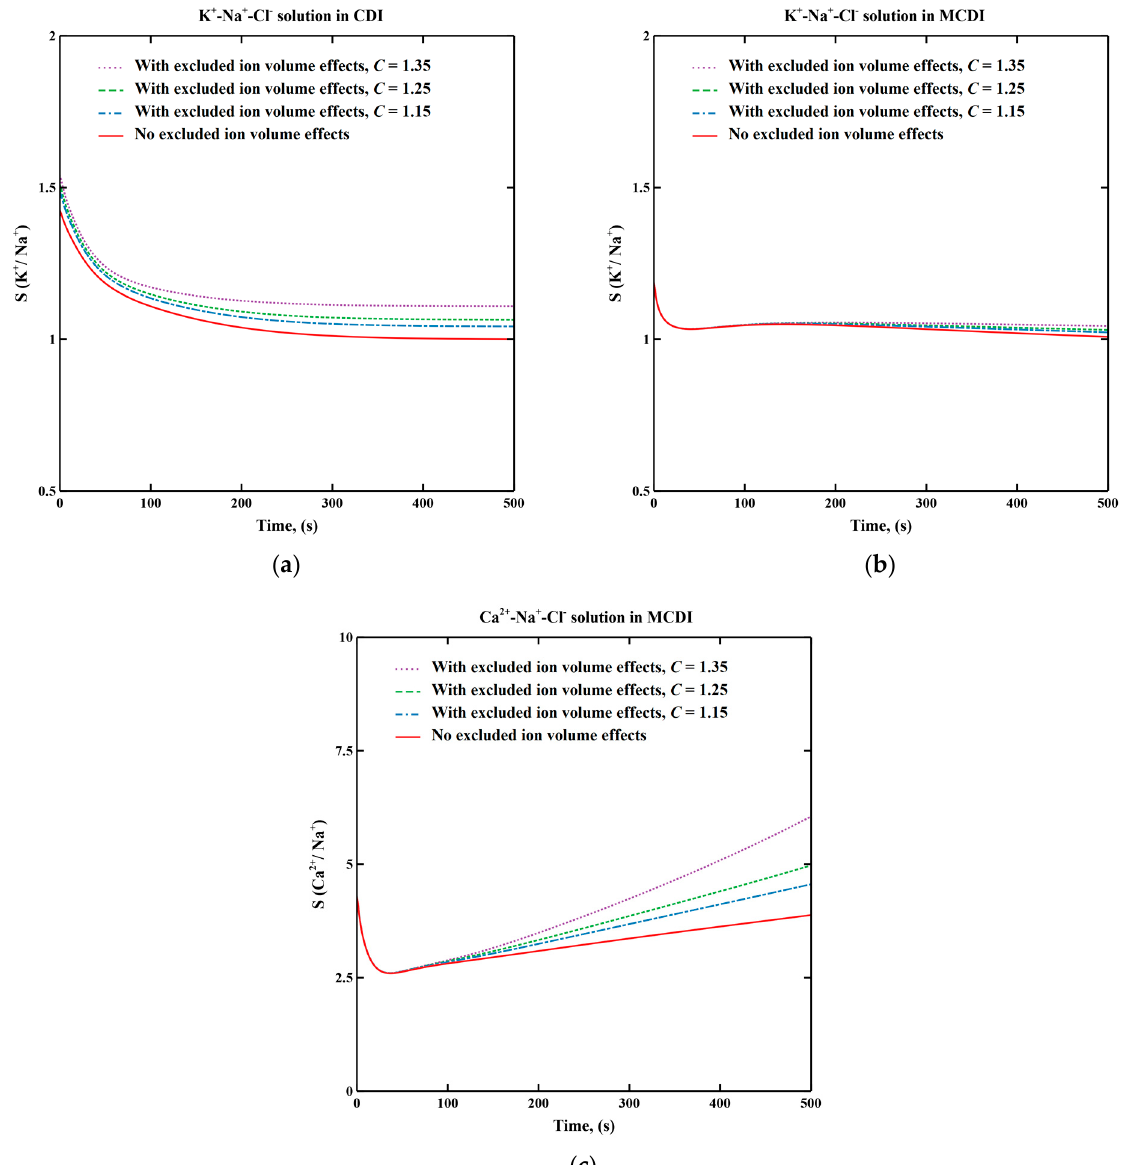
Figure 1. Transient K + selectivity in K + -Na + -Cl − solution with and without excluded ion volume effects during desalination in ( a ) capacitive deionization (CDI) and ( b ) membrane capacitive deionization (MCDI). ( c ) Transient Ca 2+ selectivity in Ca 2+ -Na + -Cl − solution with and without considering excluded ion volume effects during desalination in MCDI. Adjustable variable C is varied from 1.15 to 1.35. Applied voltage is 0.3 V. Feed concentration of each cation is 20 mol/m 3 .